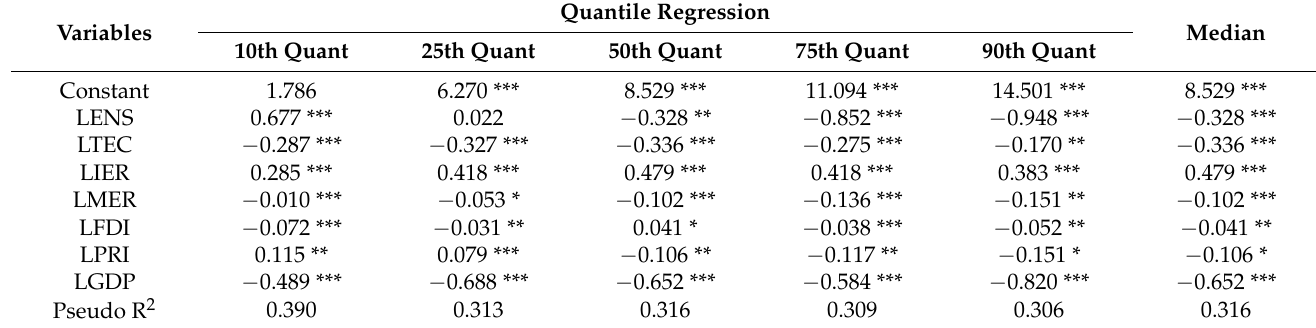
Table 7. Quantile regression